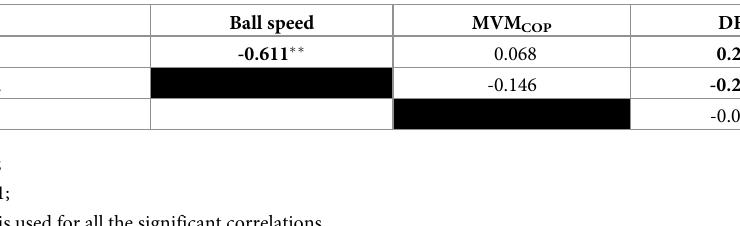
Table 2. Correlations between all the variables for all the subjects.